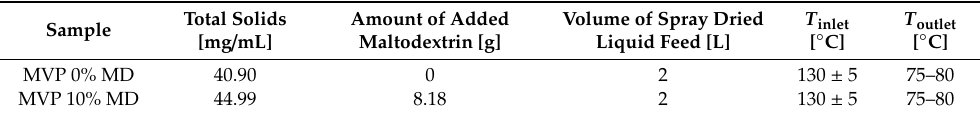
Table 1. Composition of prepared formulations prior to spray drying.